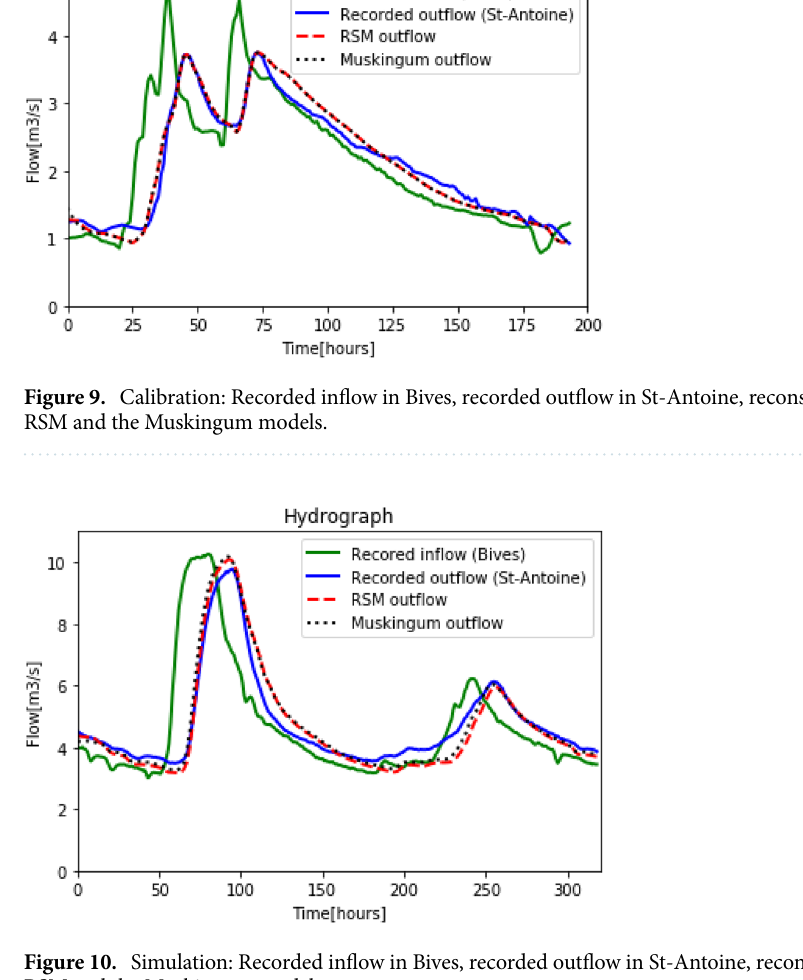
Figure 10. Simulation: Recorded inflow in Bives, recorded outflow in St-Antoine, reconstructed outflow for the RSM and the Muskingum